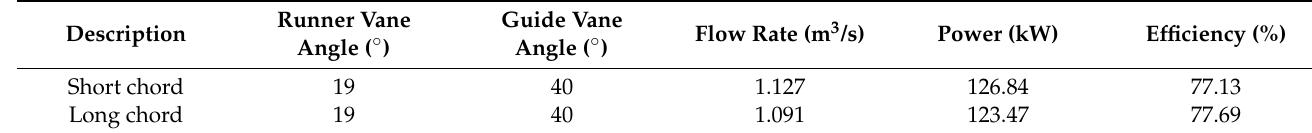
Table 6. Performance according to guide vane shape (H = 14.84 m).